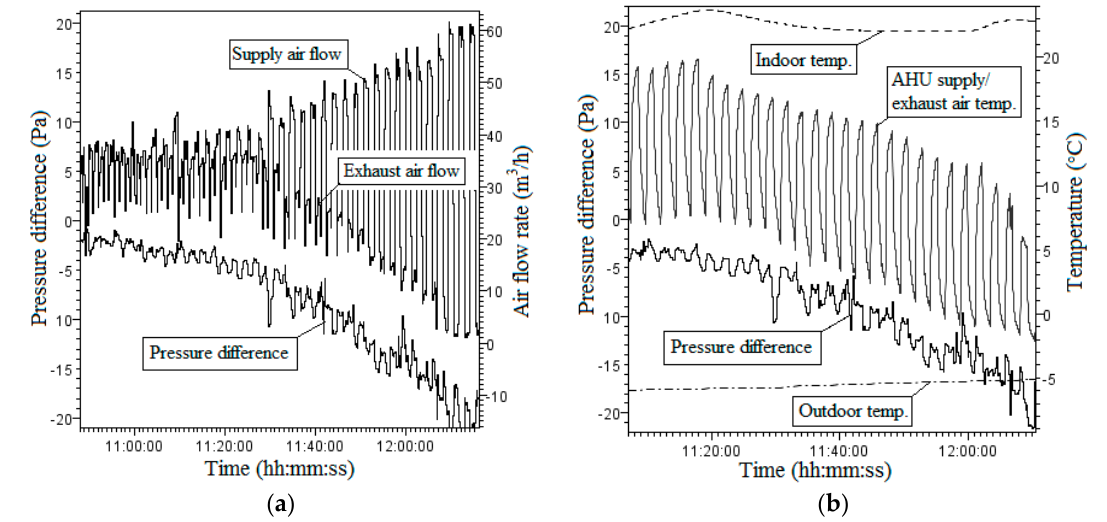
Figure 9. The results of the laboratory measurements of performance of the room unit with regenerative HEX at 75% fan power: ( a ) Pressure difference and air flows; ( b ) pressure difference and supply/exhaust air temperature.